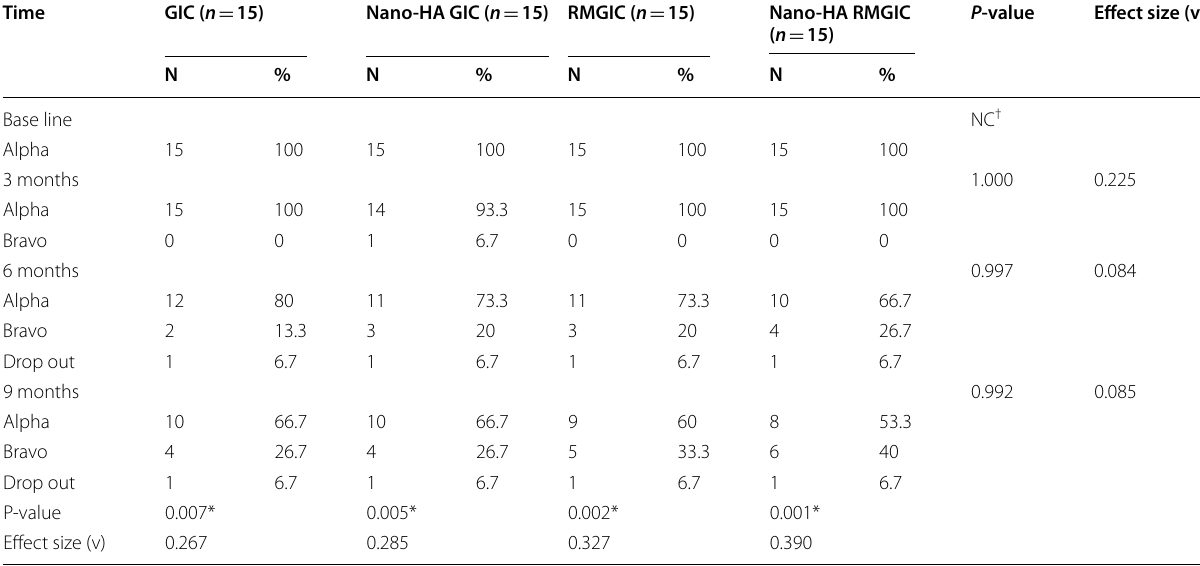
*Significant at P